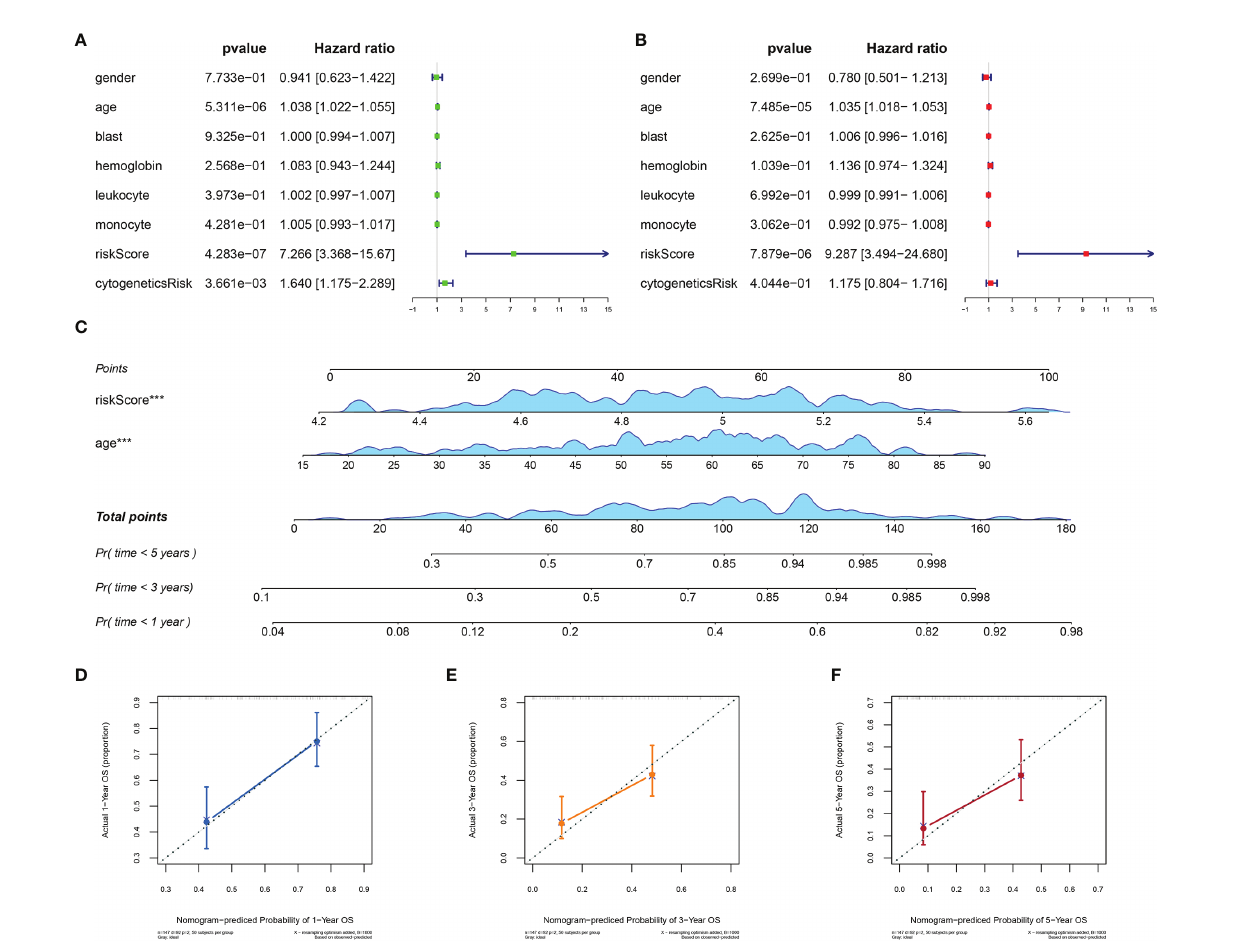
FIGURE 5 | Ef fi ciency of the MRG risk signature in prognostic prediction in AML from TCGA database. (A, B) Univariate and multivariate Cox analyses, which evaluated the risk signature ’ s independence in prognostic value in terms of overall survival in pediatric AML patients. (C) Nomograms for the probability of death at 1, 3, and 5 years. (D – F) The calibration curve of the nomograms. MRG, mitochondria-related gene; AML, acute myeloid leukemia; TCGA, The Cancer Genome Atlas. ***p < 0.001 in multivariate Cox